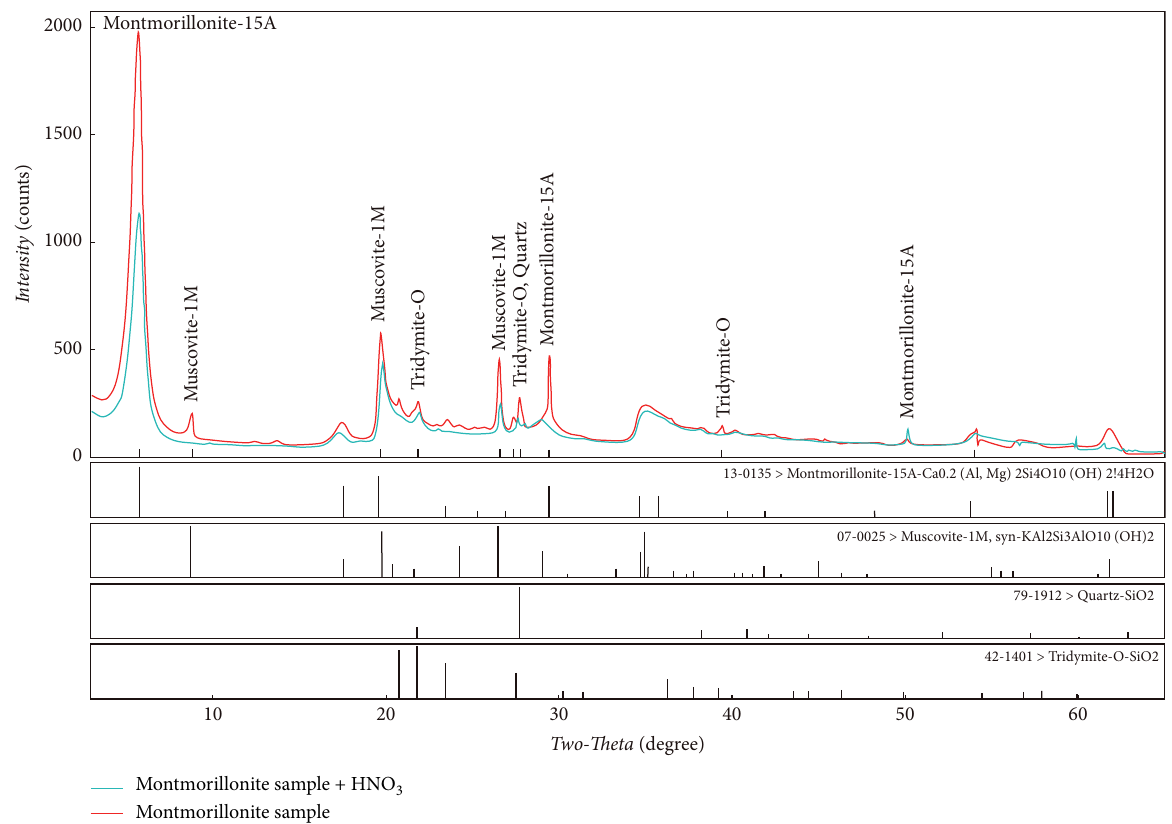
Figure 4: XRD spectrums of montmorillonite before and after soaking in HNO